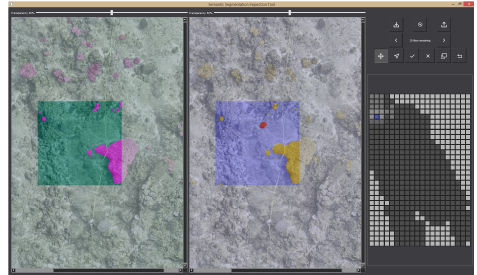
Figure 4. The semantic segmentation validation tool.